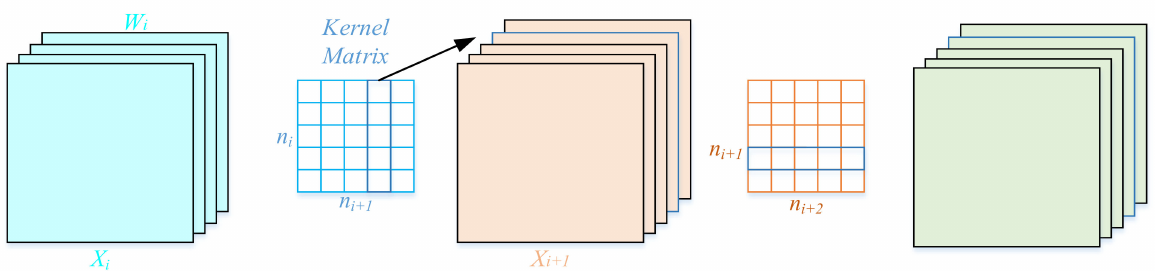
Figure 1. Schematic diagram of pruning filter method.